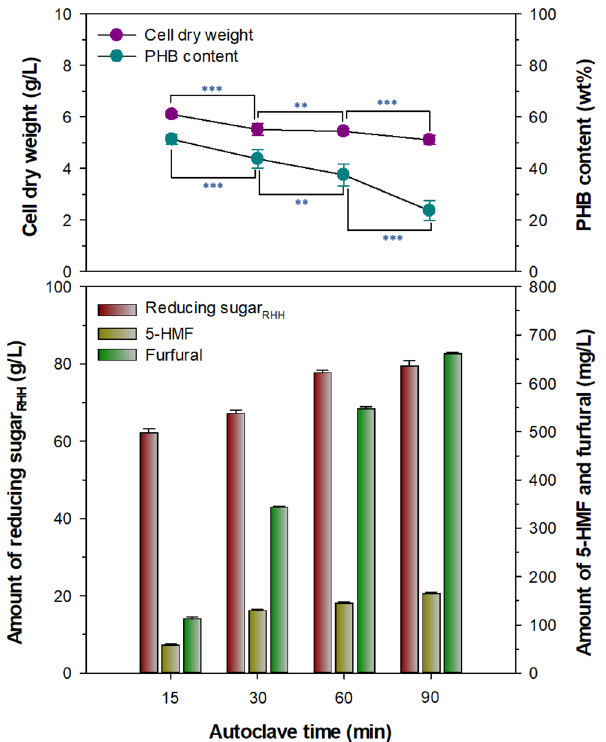
Figure 3. Effect of reducing sugar RHH samples with different compositions, which were prepared by thermochemical hydrolysis of 3% H 2 SO 4 –treated RH in an autoclave time ‐ dependent manner, on the growth and PHB production of Priestia sp. strain JY310. The values are mean ± SD of triplicate tests. p ‐ values were calculated using two ‐ tailed Student’s t ‐ test: ** p < 0.01, and *** p < 0.001.